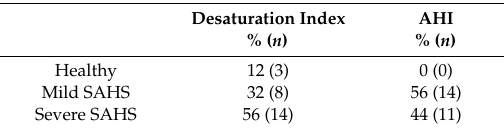
Table 3. Percentages of children with sleep apnoea–hypopnea syndrome (SAHS) according to AHI and desaturation index.